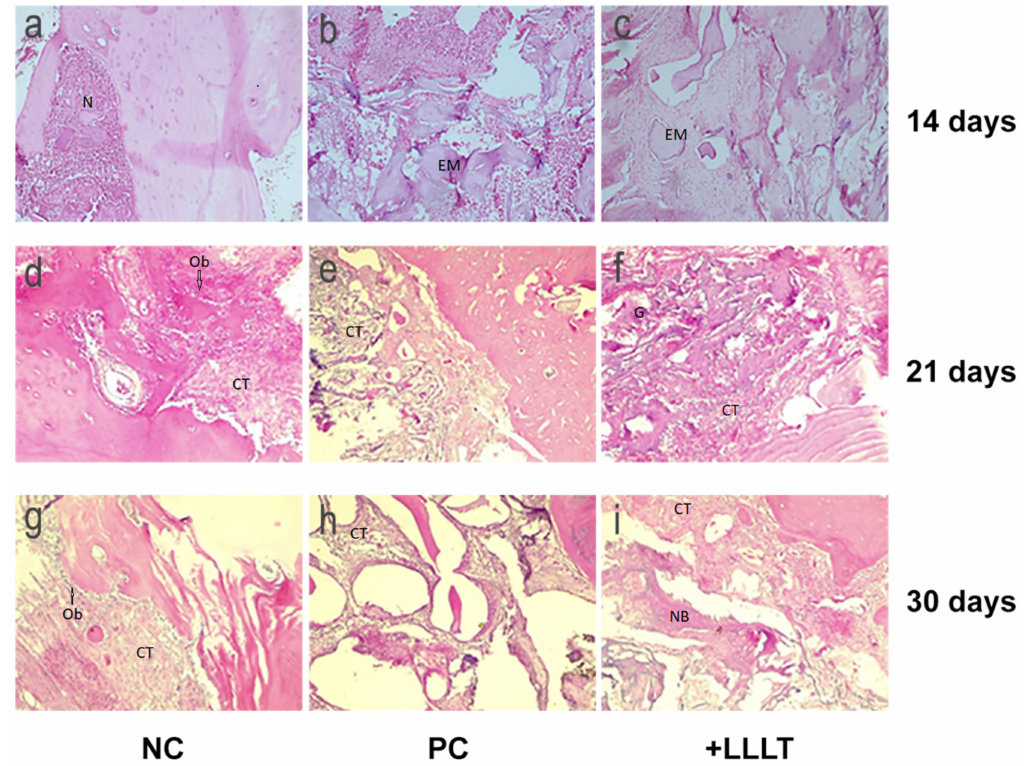
Figure 4. Histologic analysis. (a–c) Samples after 14 days of healing: ( a ) group NC, ( b ) group PC, and ( c ) group + LLLT. (d – f) Samples after 21 days of healing: ( d ) NC group, ( e ) PC group, and ( f ) + LLLT group. (g – i) Samples after 30 days of healing: ( g ) NC group, ( h ) PC group, and ( i ) + LLLT group. N-necrosis; EM-eosinophilic material; CT-connective tissue; G-granulomas; Ob-osteoblasts. HE staining, original magnification: 10 ×